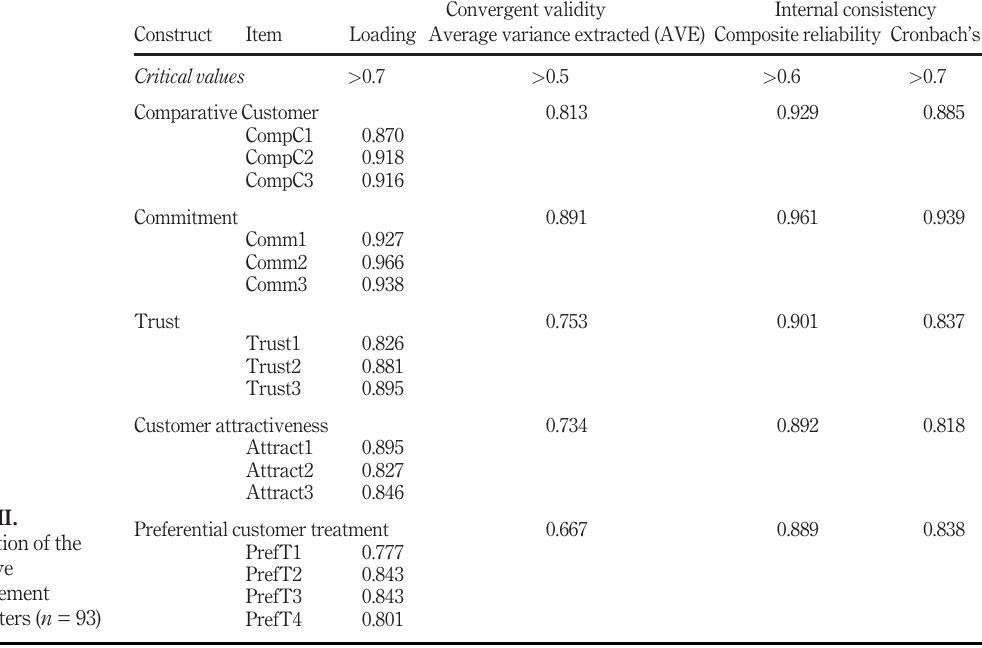
Table II. Estimation of the re fl ective measurement parameters ( n =